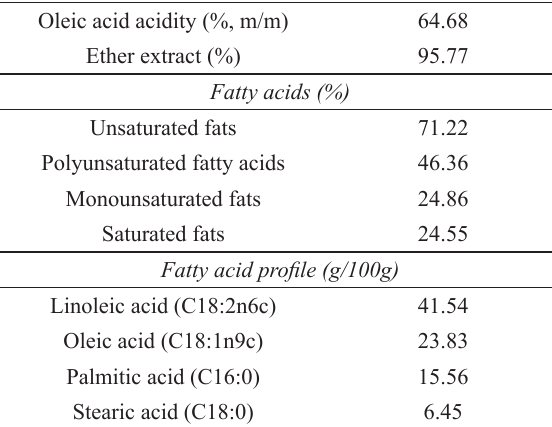
Soybean acid oil (SAO)